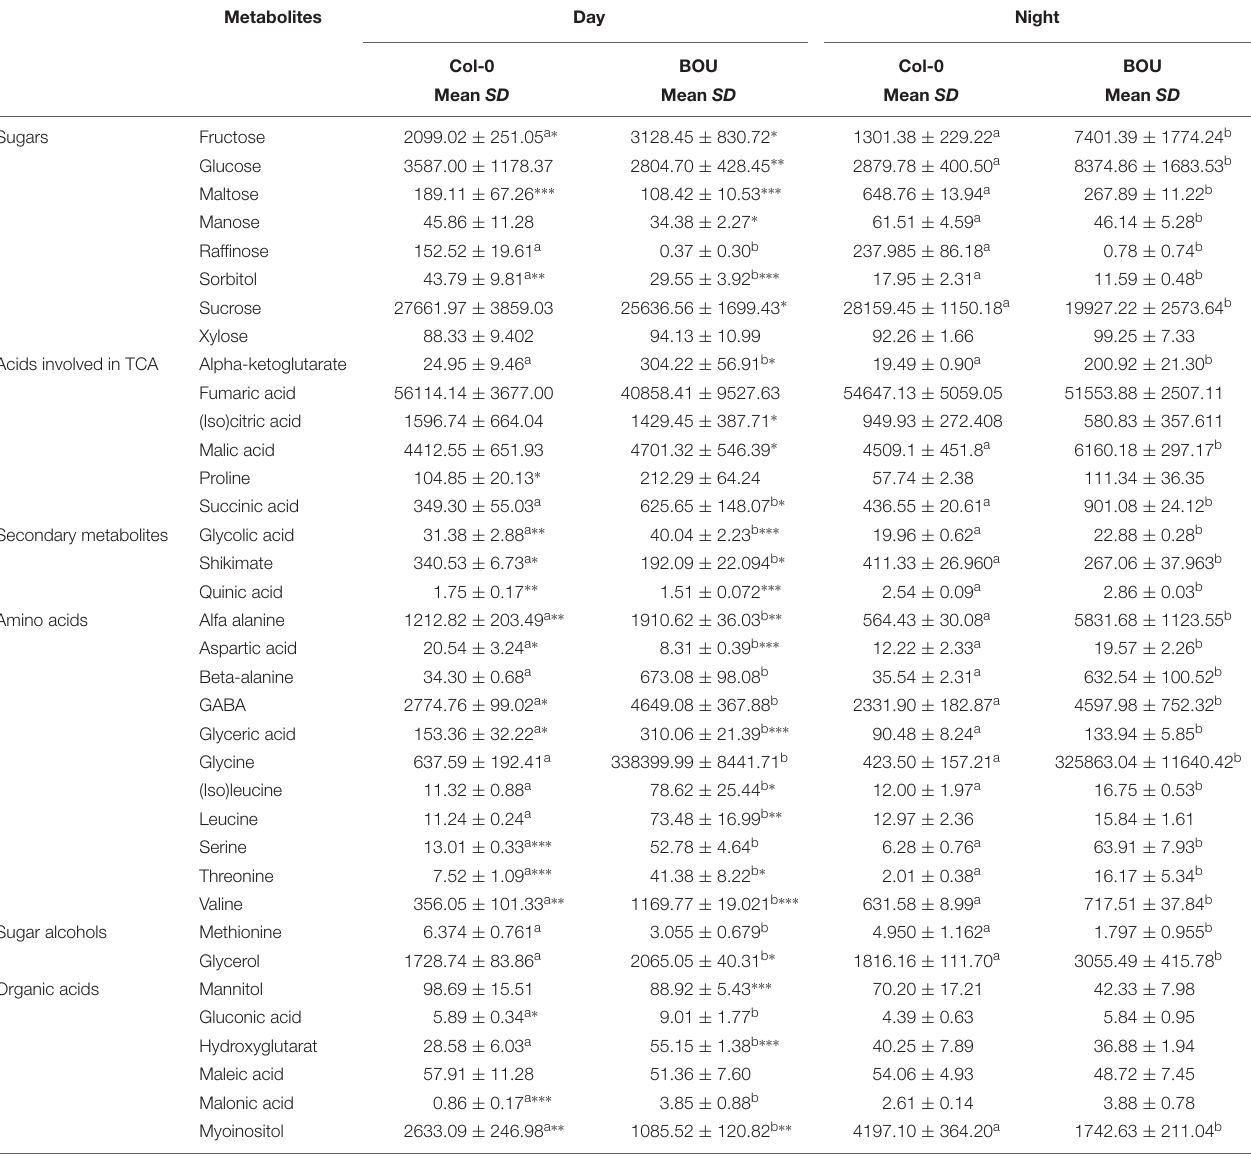
TABLE 1 | Metabolite contents present in arbitrary units (arb.u. mg − 1 FW) in leaves of Arabidopsis thaliana WT and the bou - 2 mutant at day and